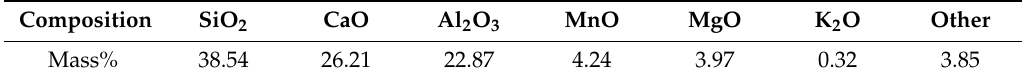
Table 1. Chemical composition of high-Al silicon–manganese alloy slag.